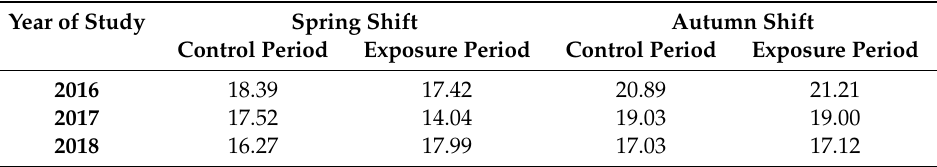
Table 2. Birth rates in the years 2016, 2017, and 2018 are